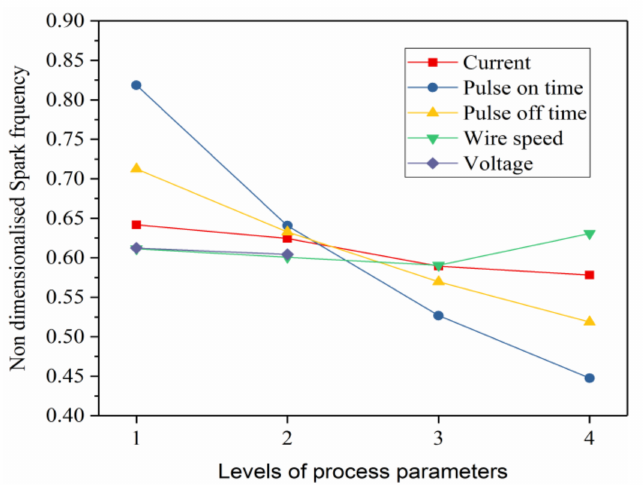
Figure 5. The spark frequency at different